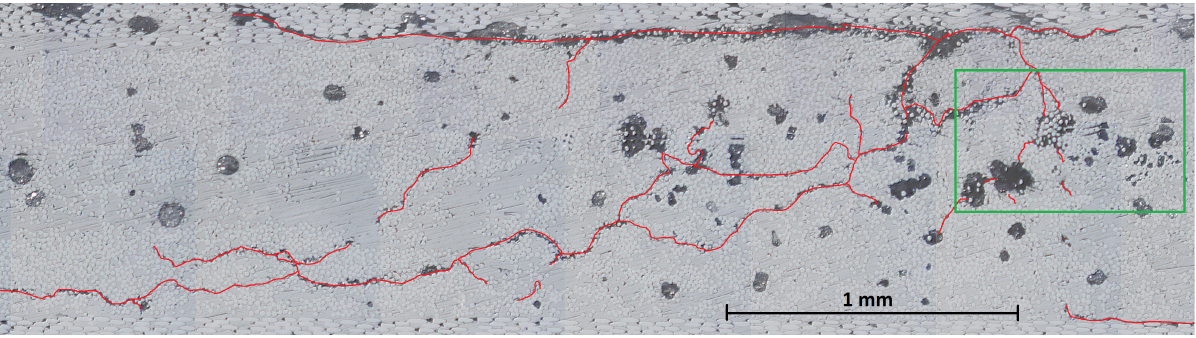
Figure 12: Microscopy of the most strained intact side of the ring with matrix cracks indicated. The green square refers to Figure